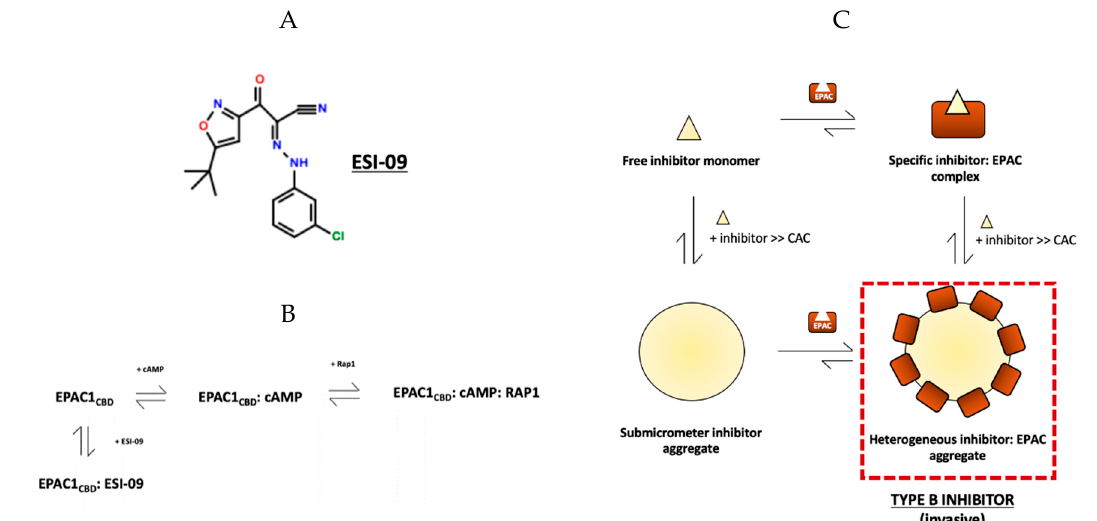
Figure 3. Specific and non-specific interactions of EPAC1 CBD and ESI-09, a competitive inhibitor. ( A ) The molecular structure of ESI-09. ( B ) Schematic representing the competitive mechanism of EPAC1 inhibition by ESI-09. ( C ) Proposed thermodynamic cycle summarizing specific enzyme:ESI binding in addition to non-specific interactions between the two species as a result of aggregation; ESI-09, as indicated on the figure, is a type-B inhibitor, forming invasive aggregates that non-specifically adsorb protein molecules and may subsequently decrease specific enzyme:ESI-binding by causing protein misfolding, sequestering protein from ligand, as well as other diverse mechanisms (Figure adapted from Boulton, S.; Selvaratnam, R.; Ahmed, R.; Van, K.; Cheng, X.; Melacini, G. Mechanisms of Specific versus Nonspecific Interactions of Aggregation-Prone Inhibitors and Attenuators. J. Med. Chem. 2019 , 62 , 5063–5079. Copyright (2019) American Chemical Society.).